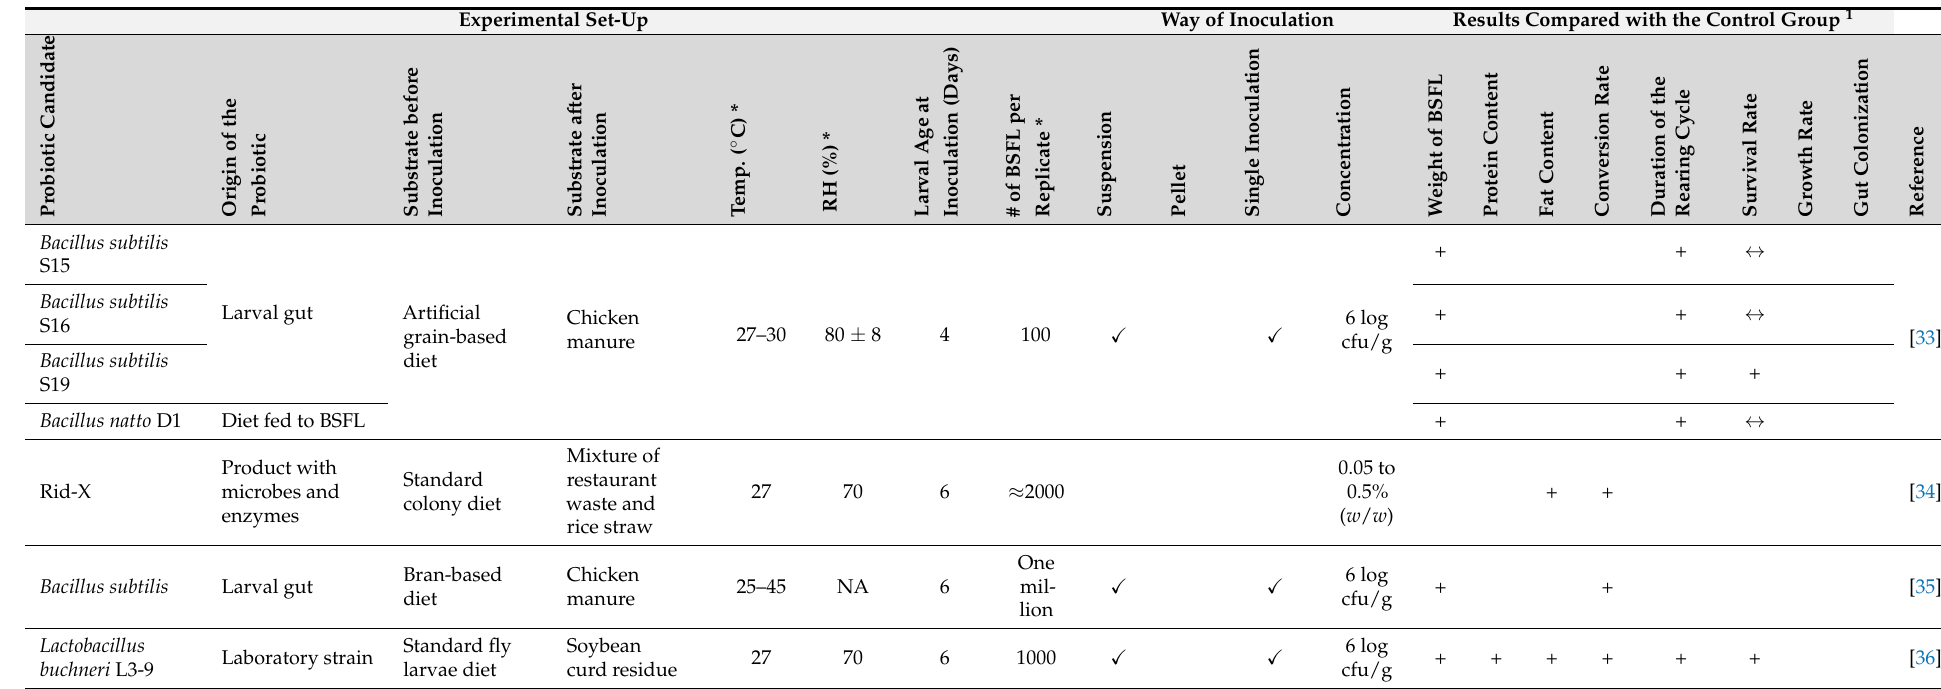
Table 1. Overview of the fifteen selected studies with details about their set-up and results. Experimental Set-Up Way of Inoculation Results Compared with the Control Group